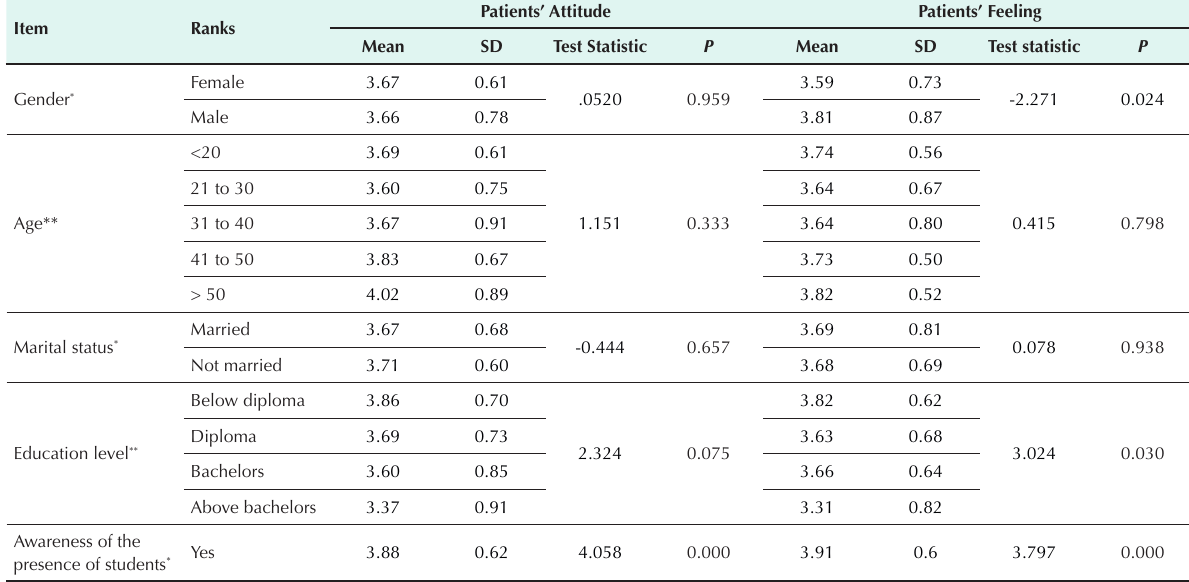
Table 4. Comparison of the Average Score of the Patients’ Feelings and Attitudes Toward the Presence of Students Separated by Demographic Variables and Patients’ Awareness Item